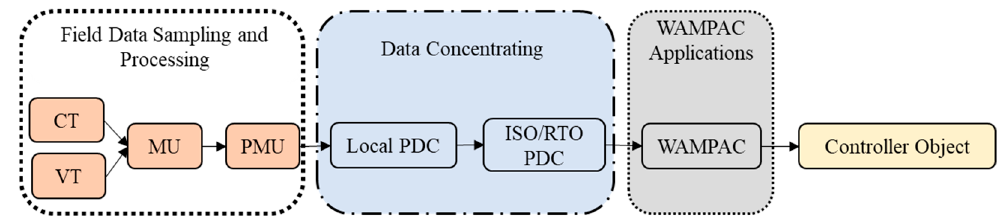
Figure 5. Phasor data processing stages in the WAMPAC Platform.